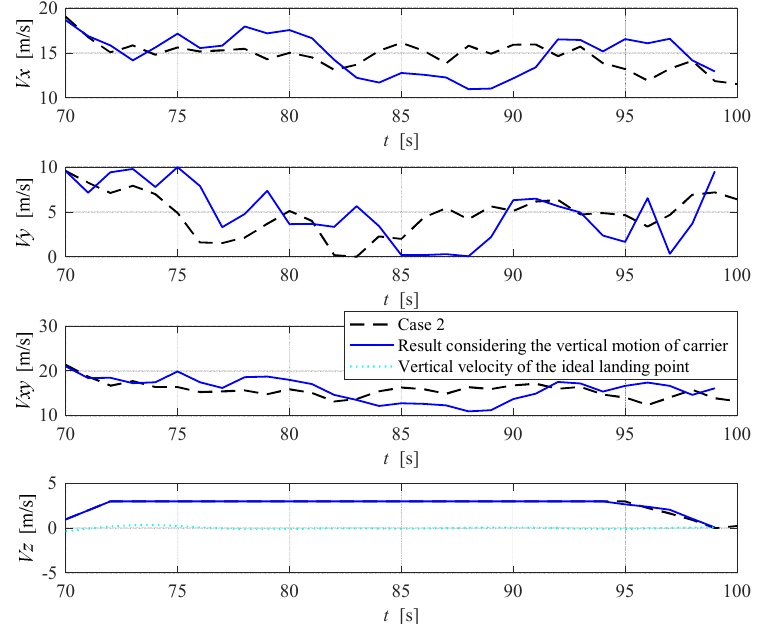
Figure 13. Velocity of the helicopter in the landing task, considering the 3D motion of the carrier. Table 5. Terminal states corresponding to case 3.